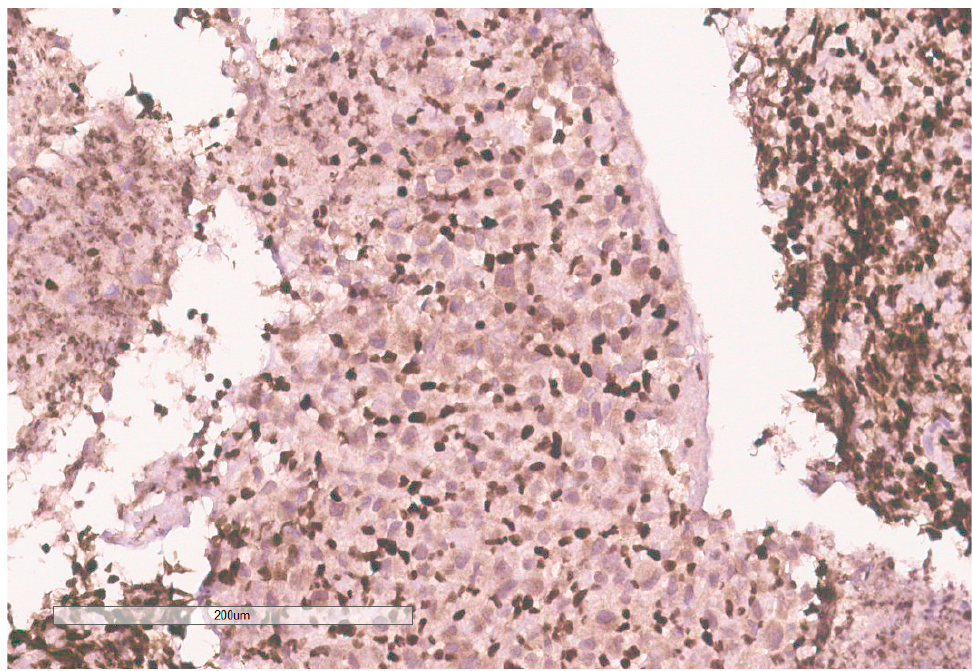
Figure 10. INI-1 (BAF47) is negative in the tumor. Lymphocytes serve as an internal positive